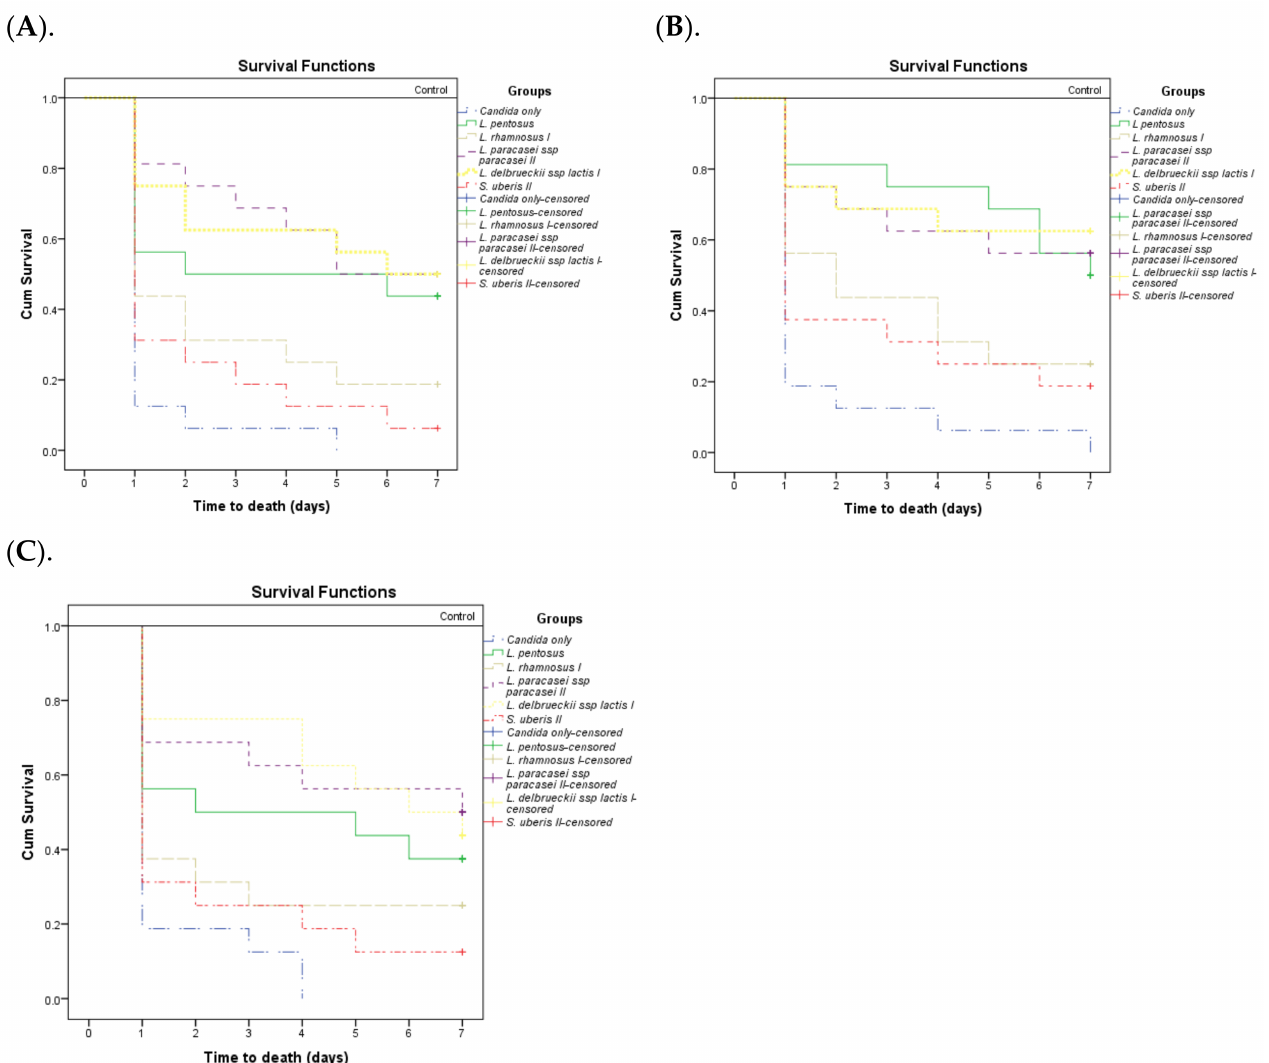
Figure 1. Pairwise comparison of the Kaplan–Meier cumulative (Cum) survival curves for G. mellonella larvae infected with Candida and injected with bacteriocin-like inhibitory substances (BLISs) from potential probiotic strains. The “ Candida only” group represents Candida without the injection of BLISs. Control refers to the negative control injected with PBS only or with MRS broth only, or the noninjected control (0% larvae mortality in all three cases). ( A ) C. albicans clinical isolate (CA